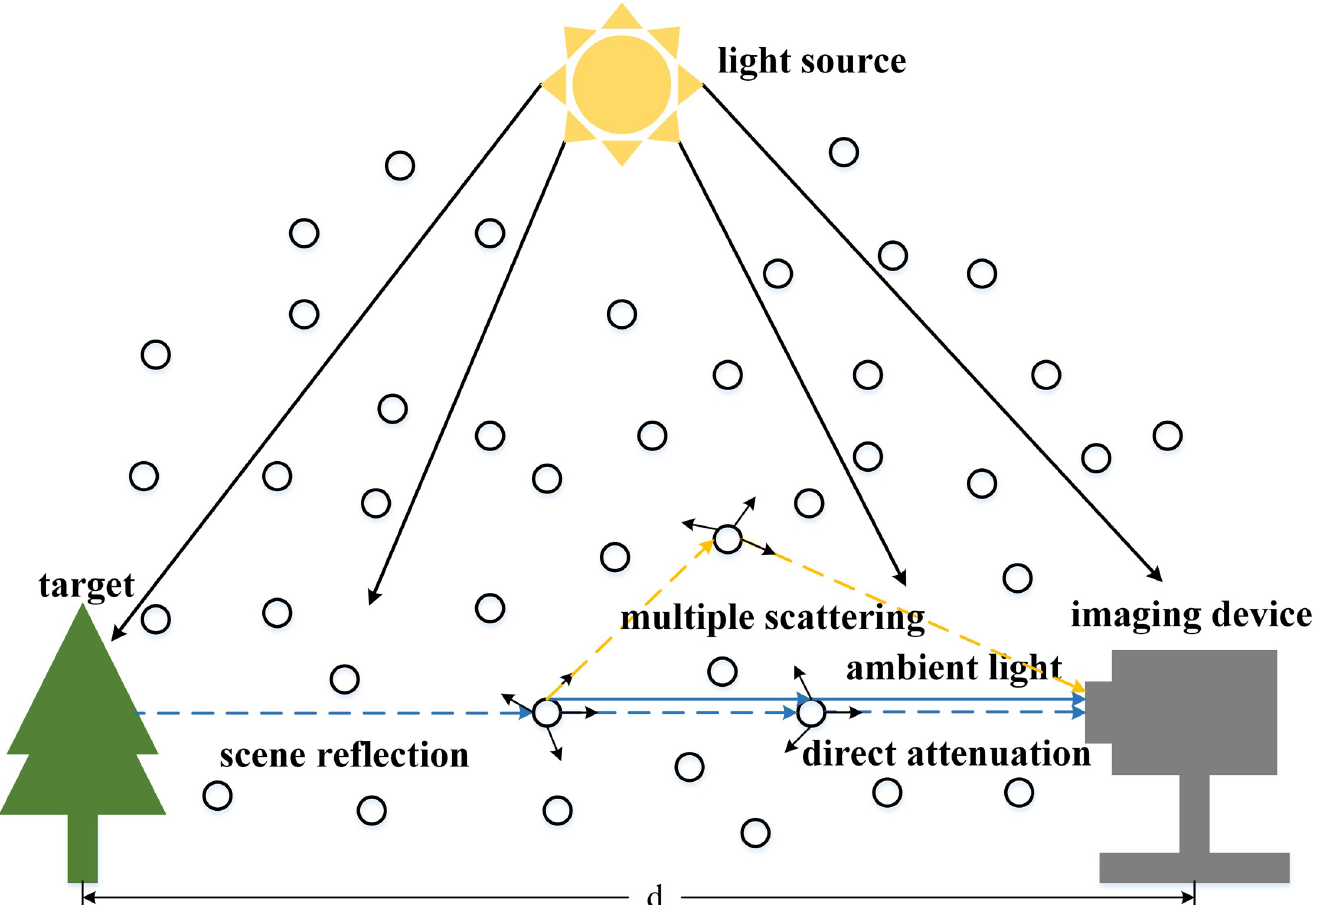
Fig 2. The imaging process using the atmospheric multiple scattering model. Different from the atmospheric single scattering model, the atmospheric multiple scattering model takes into account the multiple scattering of light in the atmosphere and can describe the interaction between the reflected light from different sites.